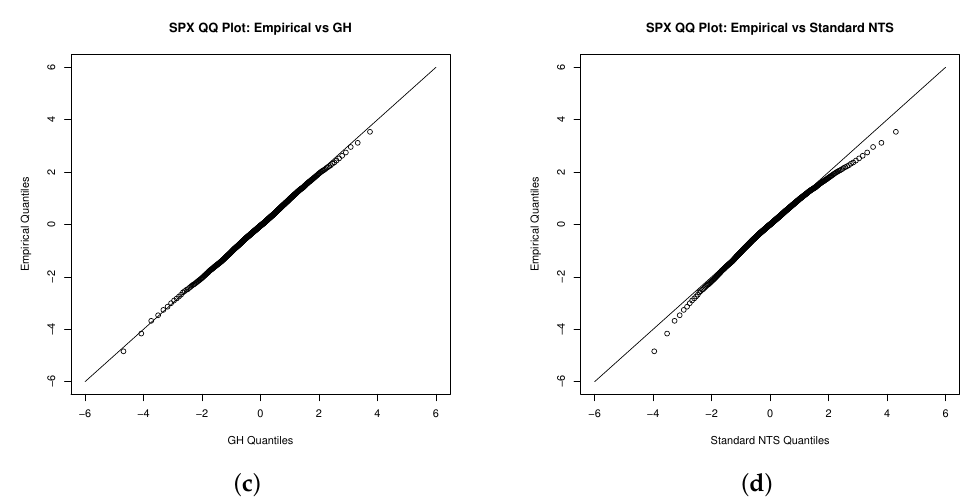
Figure 2. QQ plot for the innovations of the S&P 500 index with ( a ) the Student’s t, ( b ) NIG, ( c ) GH, and ( d ) standard NTS distribution.